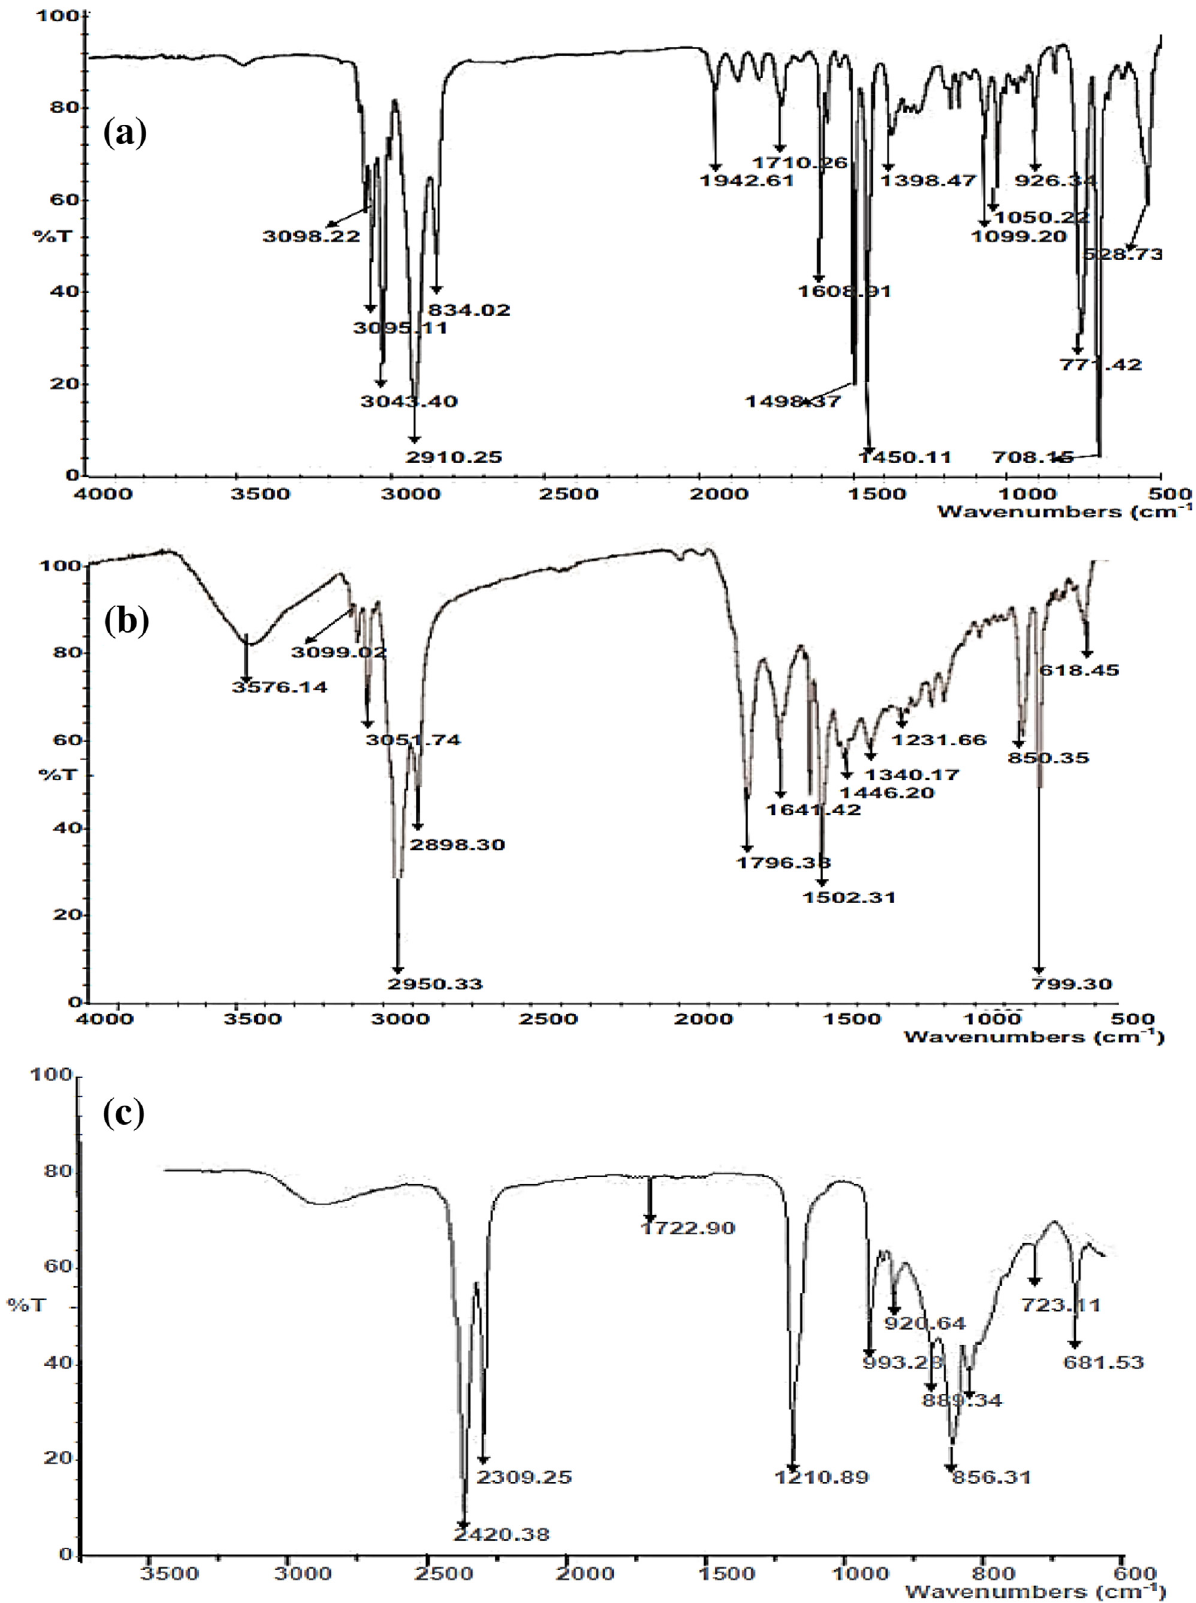
Fig. 4. FTIR spectrum for (a) un fi lled polyurethane foam, (b) polyurethane foam fi lled with dolomite particles and (c) polyurethane foam fi lled with kaolin